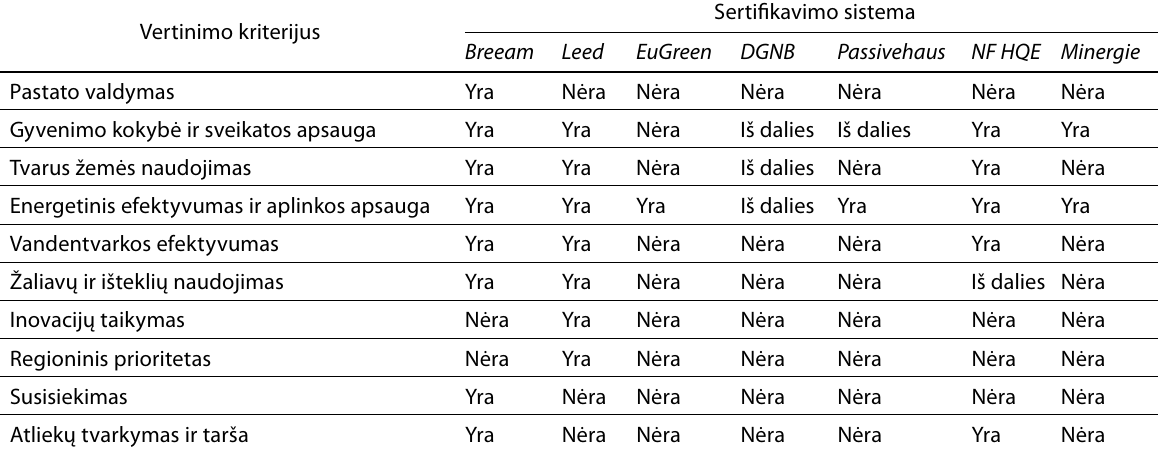
Table 1. a summary of sustainability criteria for certification schemes Vertinimo